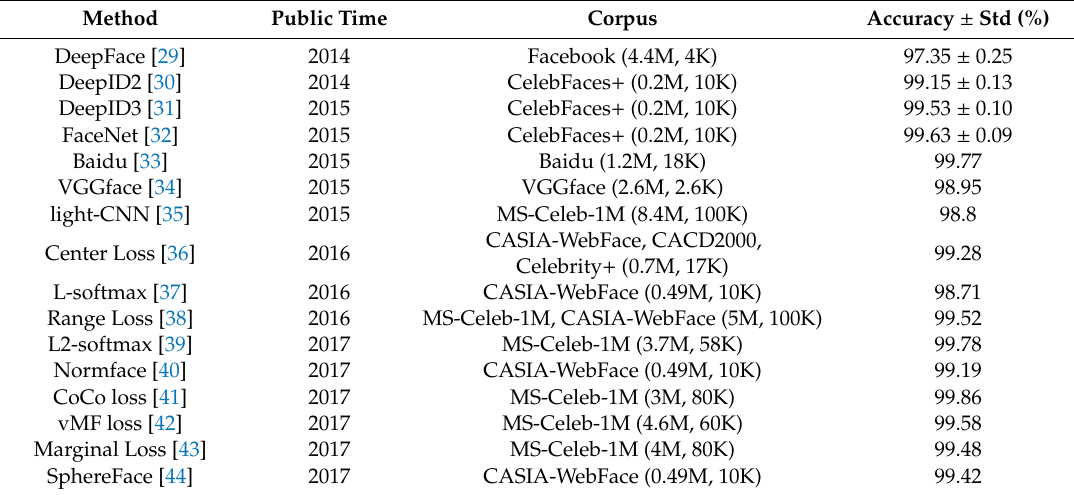
Table 1. Comparison of computer vision (CV)